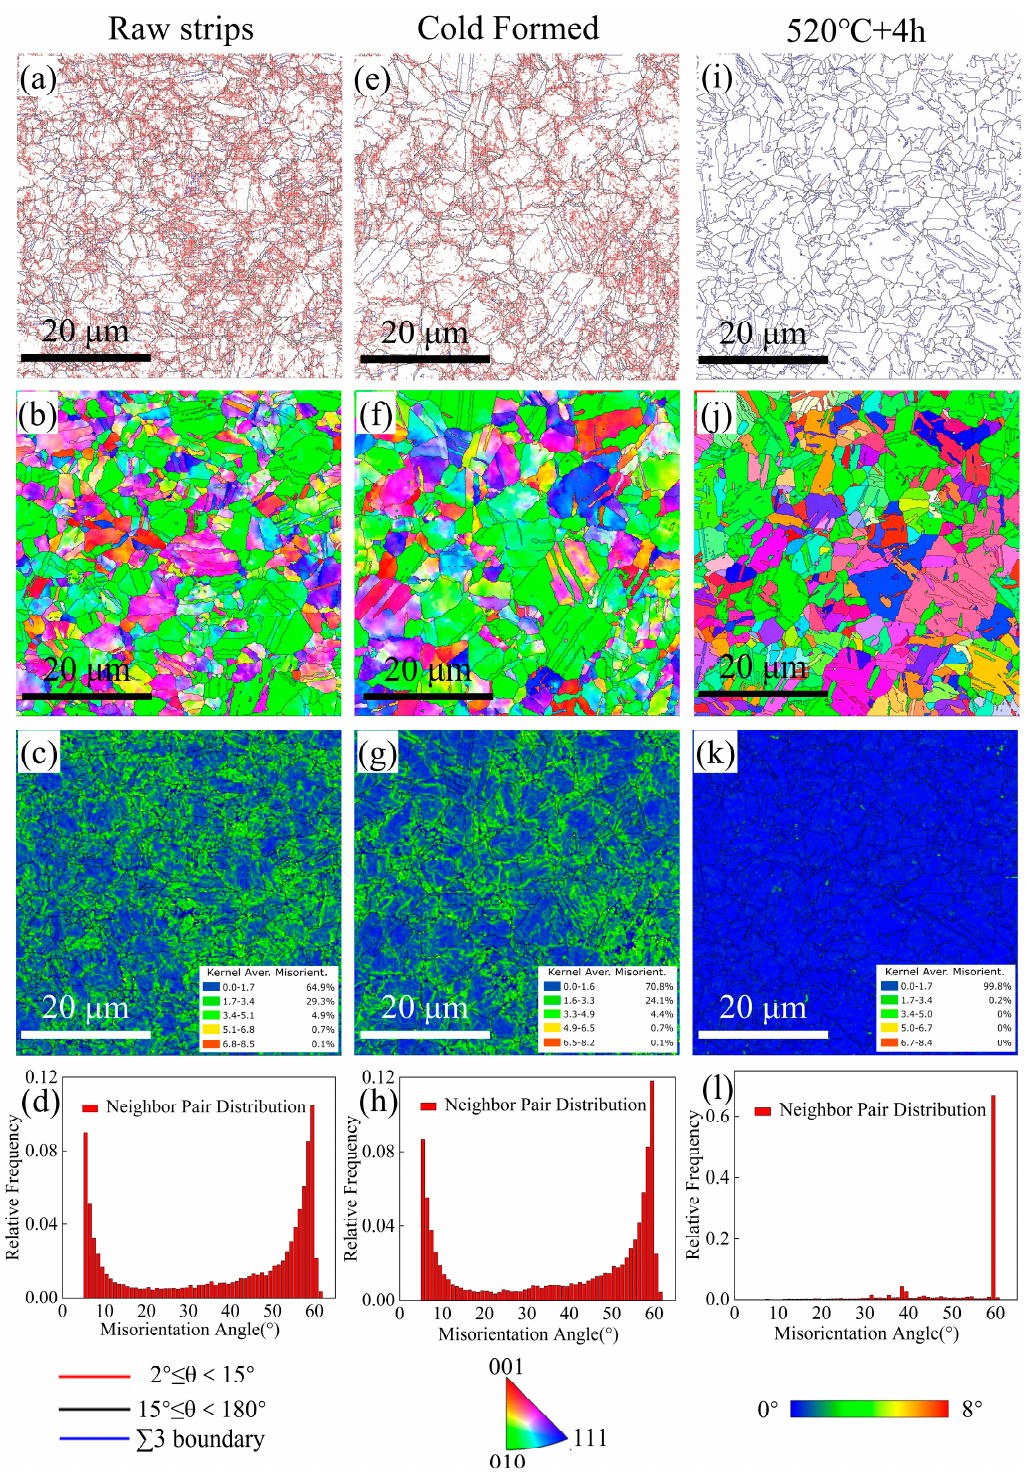
Figure 11. Results of EBSD studies: GB ( a , e , i ), IPF ( b , f , j ), KAM ( c , g , k ), and MAD ( d , h , l ) maps of raw strips ( a – d ), cold-formed STACER ( e – h ) and winding and stabilization STACER specimens ( i – l ). Table 4. GBs and average grains size of the EBSD results.